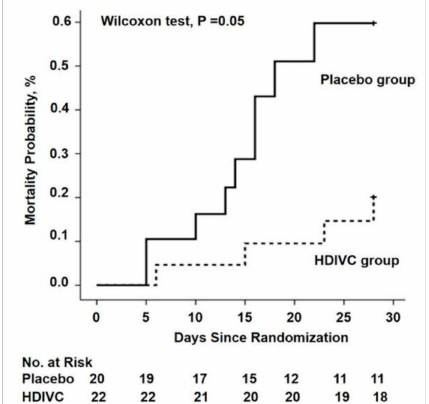
Figure 2. The 28-day mortality from randomization (day 1) to day 28 in a trial of high-dose intravenous vitamin C (HDIVC) in patients with COVID-19. Kaplan–Meier analysis was used to estimate the 28-day mortality and survival curves were compared with the Wilcoxon test ( p = 0.05) among severe COVID-19 patients (baseline SOFA score ≥ 3). Cox regression was used as multiple comparisons (HR, 0.32 (95%CI, 0.10–1.06); p = 0.06). HDIVC—high-dose intravenous vitamin C. Reproduced with permission from Zhang J. et al.